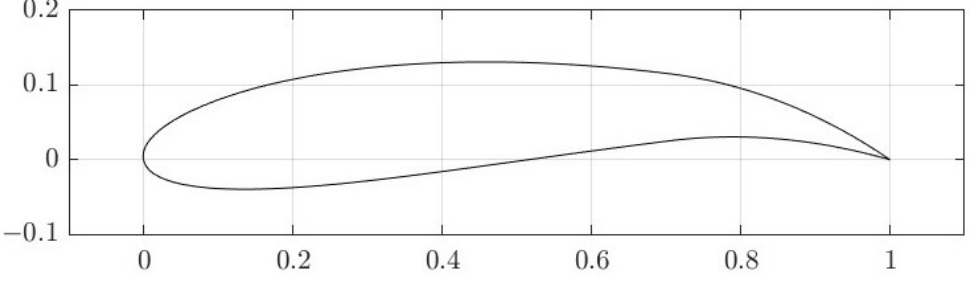
Figure 1. NACA 7715 aerofoil (1 m chord length) [2].